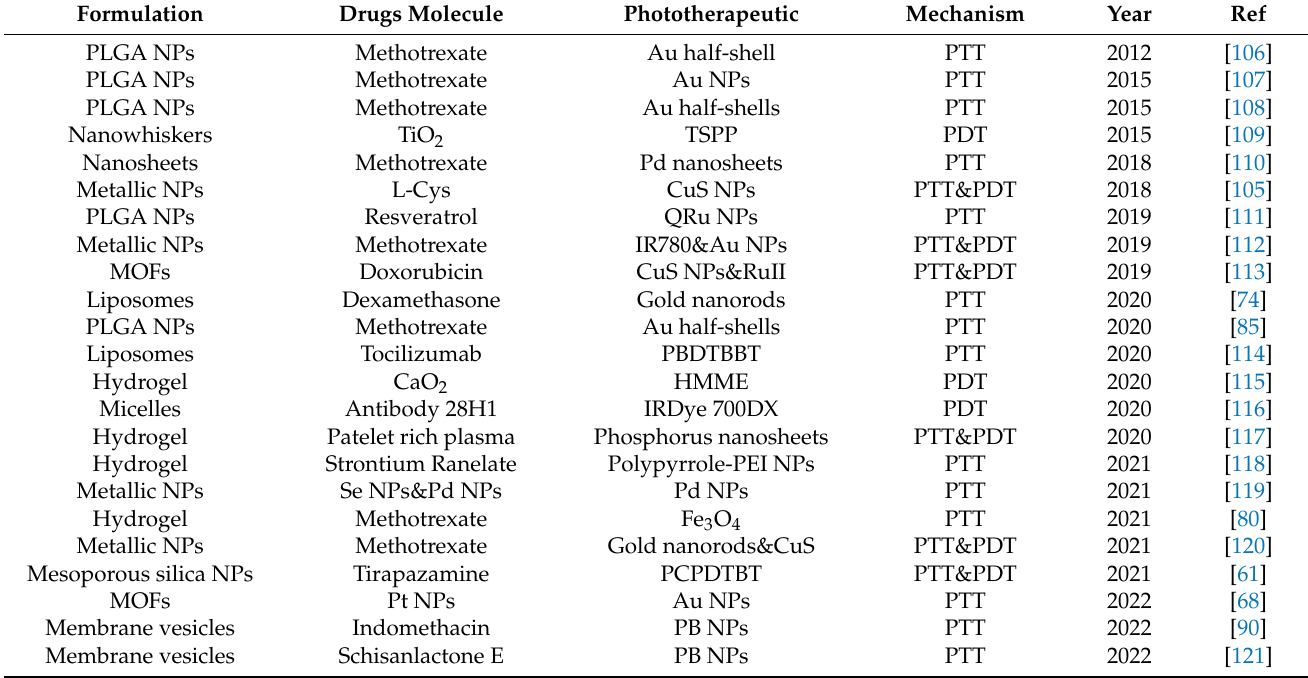
Figure 4. A brief overview of the different mechanisms of PDT and PTT therapies. They tend to rely on the co-delivery of photosensitizers and photothermal and phototherapeutic agents with both abilities. Table 1. Co-delivery of phototherapy utilizing nanocarriers.